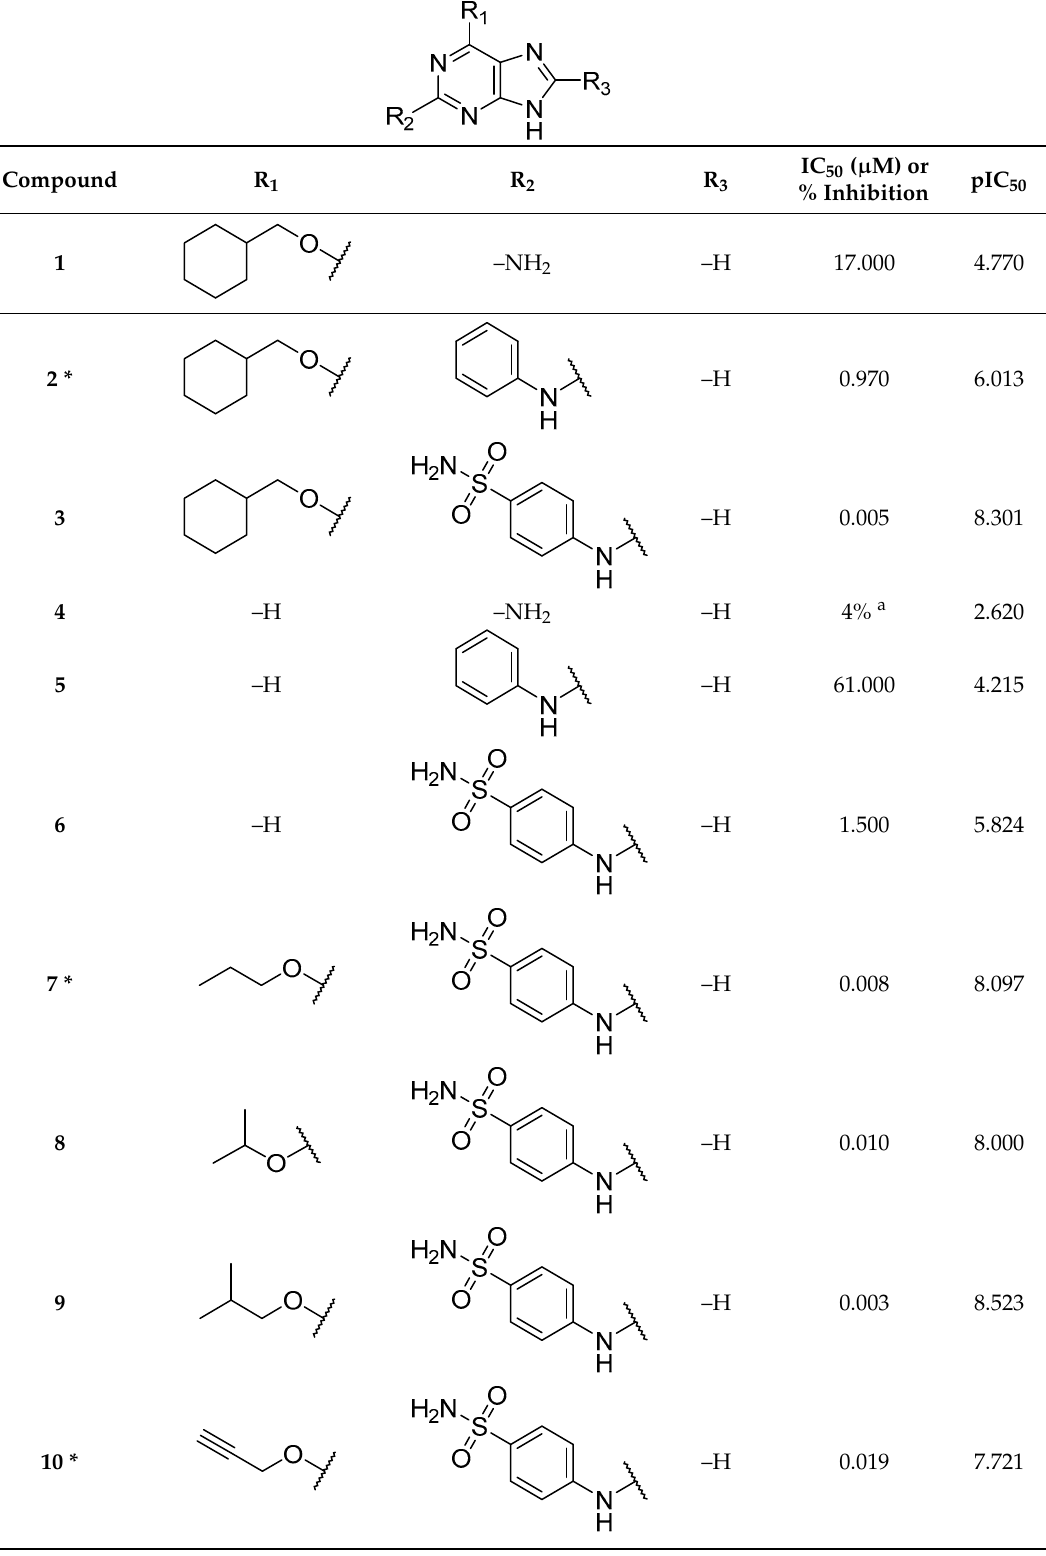
Table 4. The structures and the pIC 50 values of the dataset compounds.